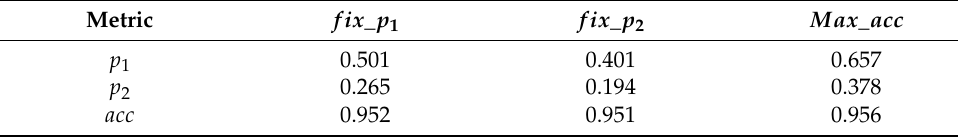
Table 5. Best performance of the